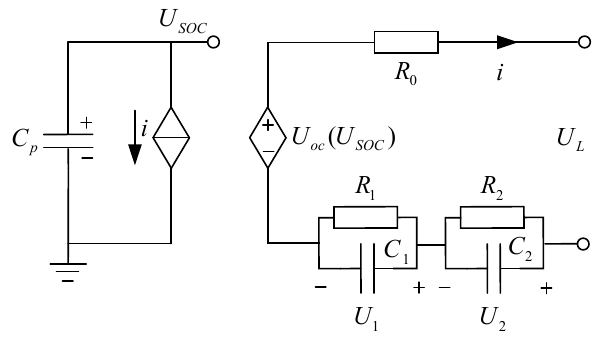
Figure 1. Improved second-order resistor-capacitor (RC) equivalent circuit model.